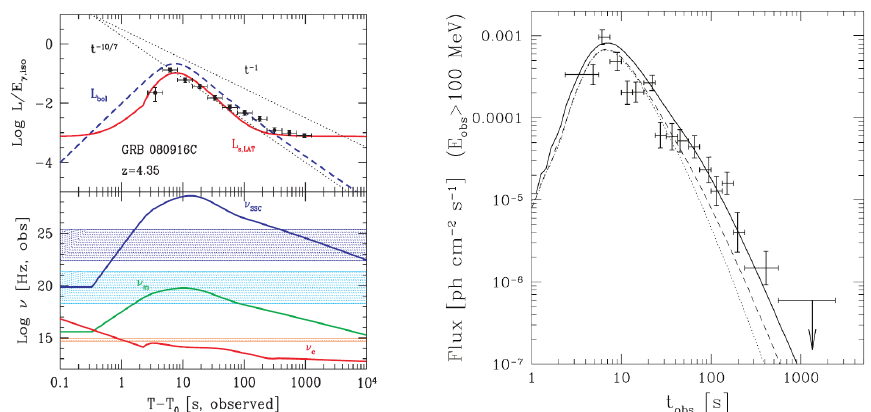
Figure 3. ( Left ) Radiative afterglow with e ± enrichment model fit to the lightcurve of GRB 080916C [112]. In the top-panel, the red curve shows the Fermi -LAT luminosity, the dashed blue curve is the expected bolometric luminosity, and the two dotted black curves show the expected temporal slopes of the afterglow luminosity when the blast wave is adiabatic ( L γ ,iso ∝ t − 1 ) or ra- diative ( L γ ,iso ∝ t − 10/7 ) for a uniform circumburst medium. The bottom panel shows the temporal evolution of the characteristic frequencies of synchrotron and SSC emission. The shaded regions show the energy ranges of the LAT [(0.1 − 100)GeV] and GBM [(8 − 10 3 )keV] instruments, as well as the optical energy range (U and R filters). Right : Pre-accelerated and pair-loaded CBM afterglow model fit to the Fermi -LAT lightcurve of GRB 080916C [56] (©AAS. Reprodued with